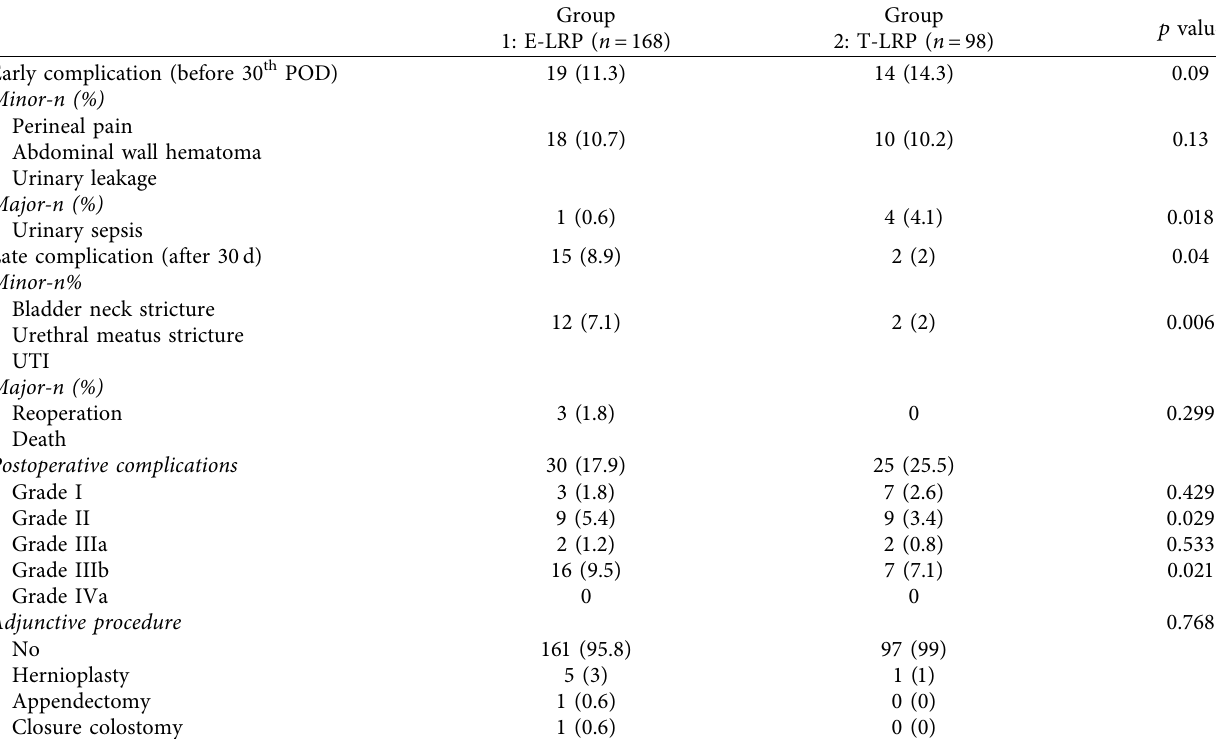
Table 3: Postoperative